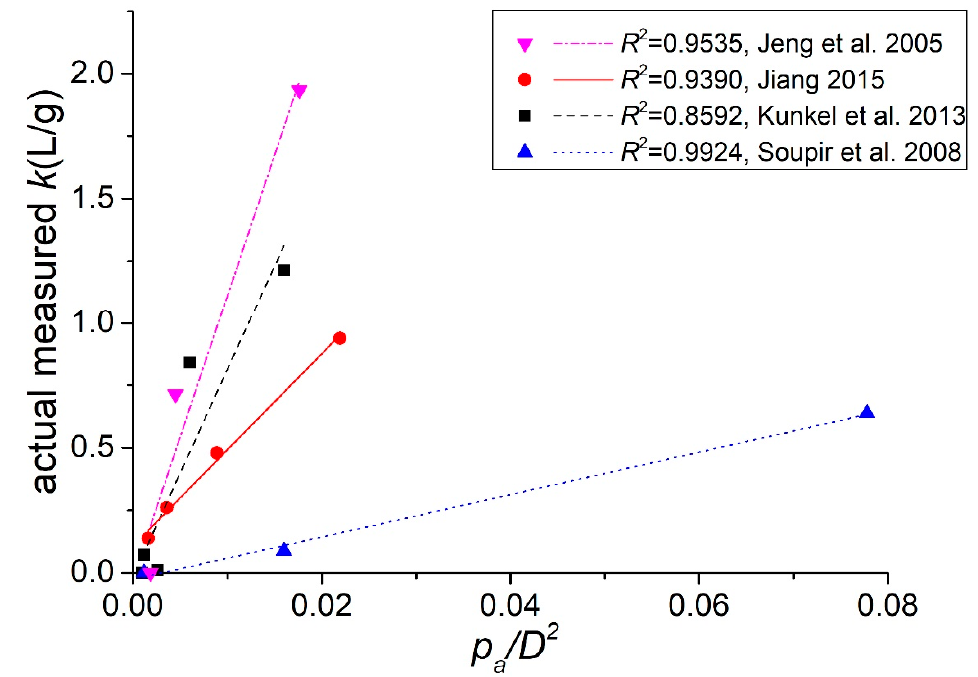
Figure 4. The relation between the calculated p ap / D 2 from Equation (9) and the measured k . Measured data were obtained from literature [1,14,15,41] and the corresponding partition coefficient was calculated for different particle sizes from 8 μ m to 62 μ m. Lines are linear fittings of the corresponding data.